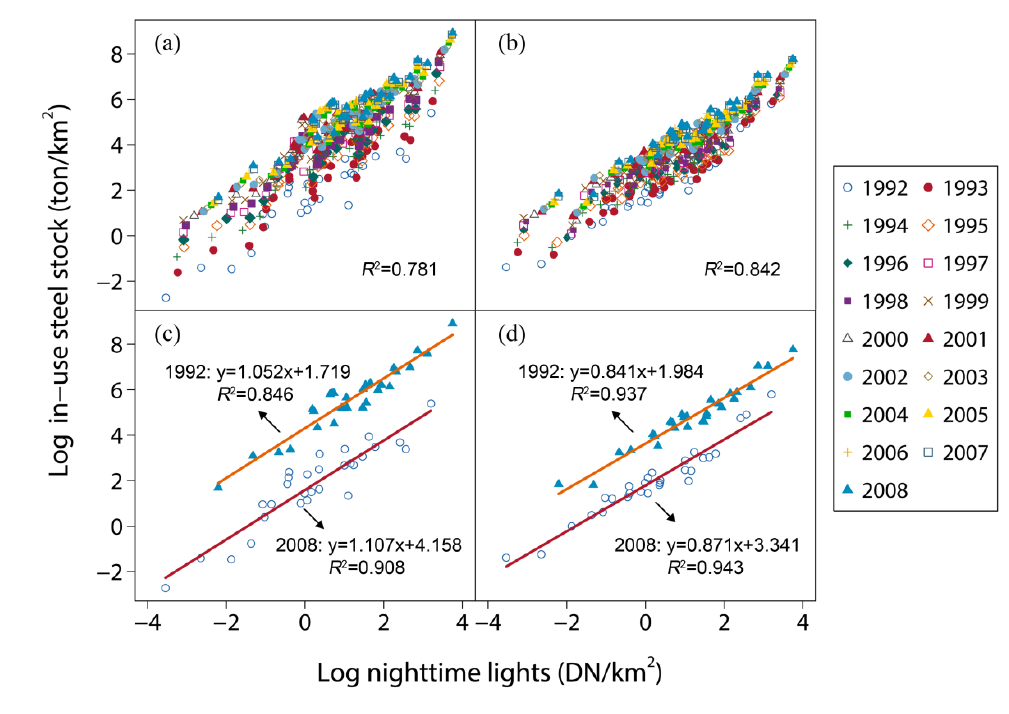
Figure 4. Scatter plots for provincial variables over the entire period: ( a ) nighttime lights versus IUSSB; ( b ) nighttime lights versus IUSSCE. Scatter plots with linear regression lines for variables in 1992 and 2008: ( c ) nighttime lights versus IUSSB; ( d ) nighttime lights versus IUSSCE. Solid lines in black, orange, and red are linear regression